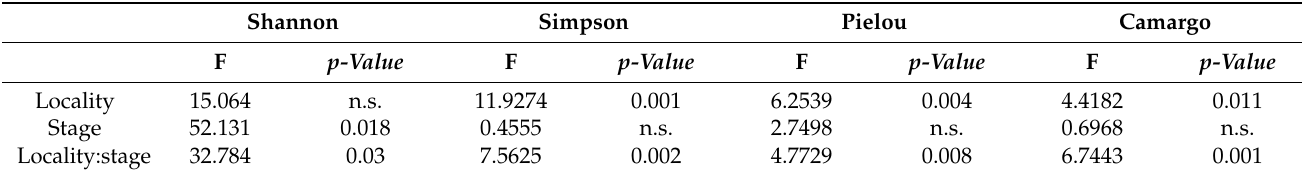
(Table S6) confirmed the high relevance of localities (sites, F = 1.64, p < 0.001) but also confirmed the contribution of the phenological stage (F = 1.17, p < 0.01) and their interaction (F = 1.19, p < 0.001) in the sample